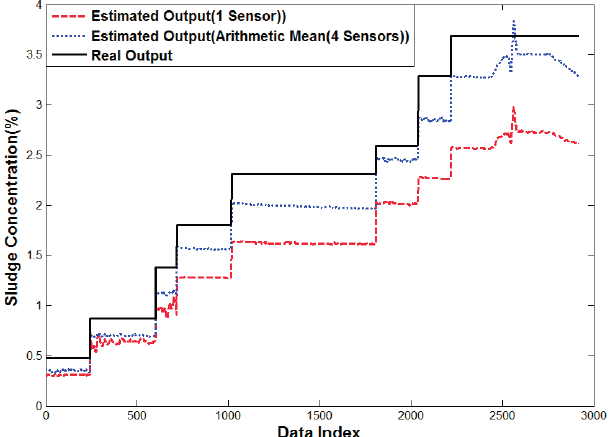
Figure 13. Performance curve of one sensor case and Method 1.